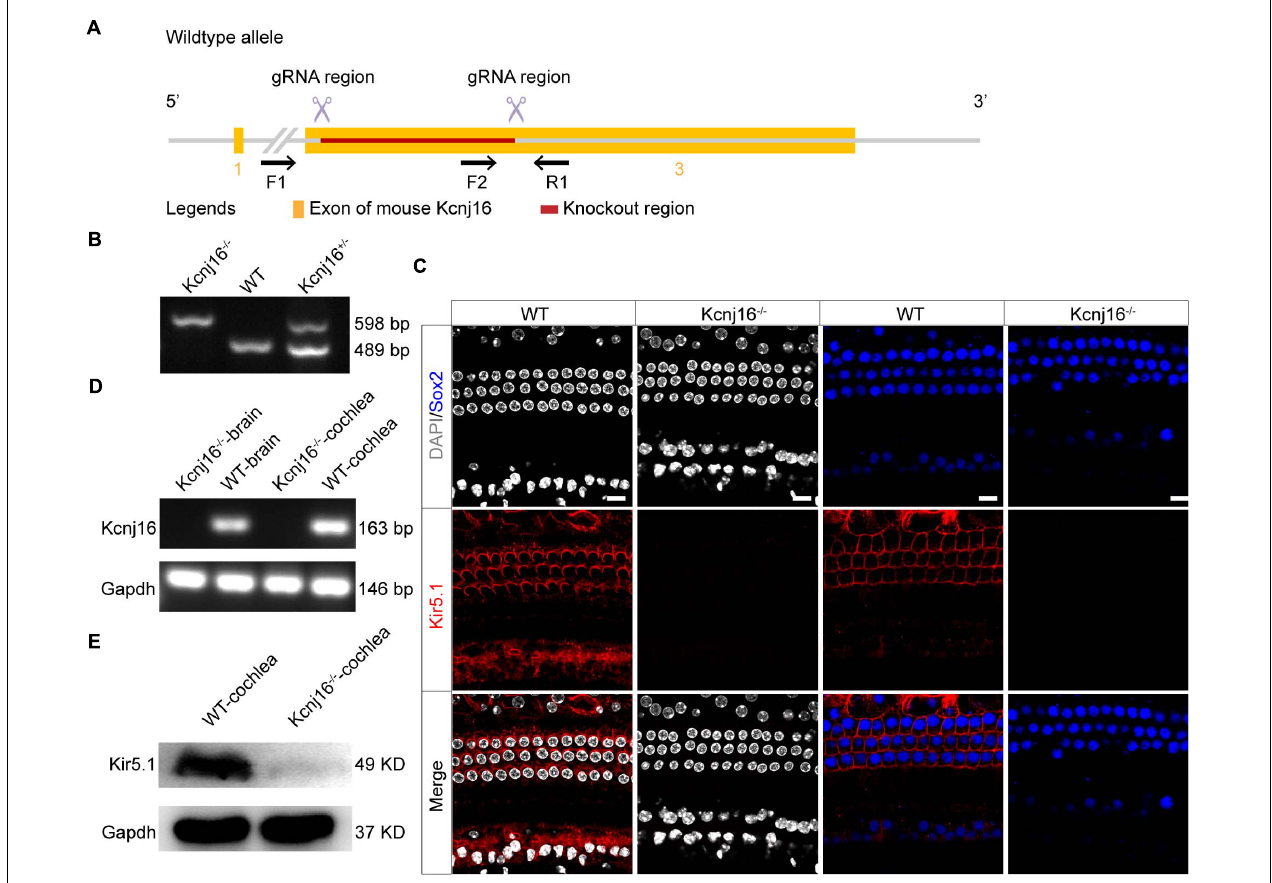
FIGURE 3 | Analysis of Kir5.1 expression in Kcnj16 − / − mice at the protein and mRNA level. (A) Overview of the targeting strategy. (B) PCR results showing genomic DNA of a homozygous ( Kcnj16 − / − ; 598 bp), a wild-type (WT; 489 bp), and a heterozygous ( Kcnj16 + / − ; 489 and 598 bp) mouse. Primers are shown in the Supplementary Table 1 . (C) The cochleae of P30 Kcnj16 − / − mice were immunolabeled with Kir5.1 antibodies. Scale bar = 10 µ m. Images were taken from the middle turns of the sensory epithelium. There was no difference in the immunolabeling of Kir5.1 from the apical to basal turns (data not shown). (D) RT-PCR was performed to identify the presence the Kcnj16 mRNA. RNA was extracted from the cochlea and from total brain tissue of P30 Kcnj16 − / − and WT mice, and GAPDH was used as the internal control. Primers are shown in the Supplementary Table 2 . (E) Western blot was performed using antibodies against Kir5.1. Proteins from the cochlea were extracted from P30 Kcnj16 − / − and WT mice, and GAPDH was used as the internal